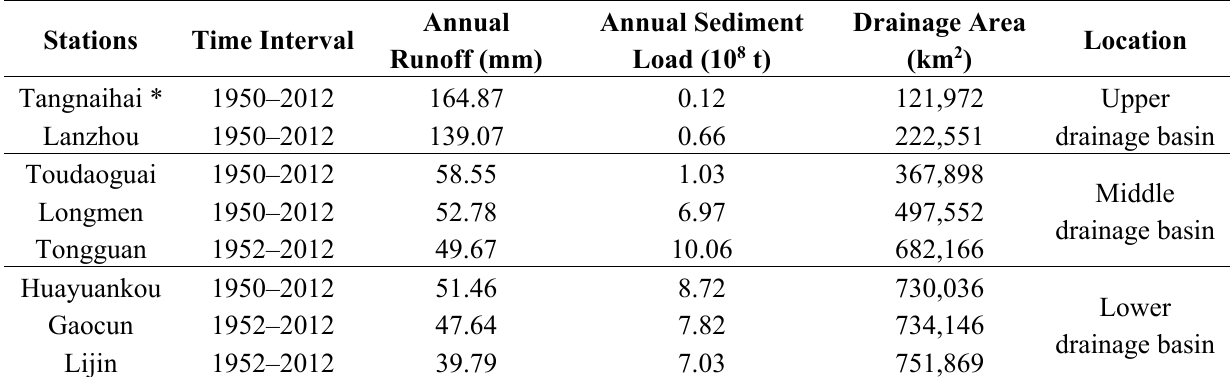
Table 1. List of the hydrological stations used in this